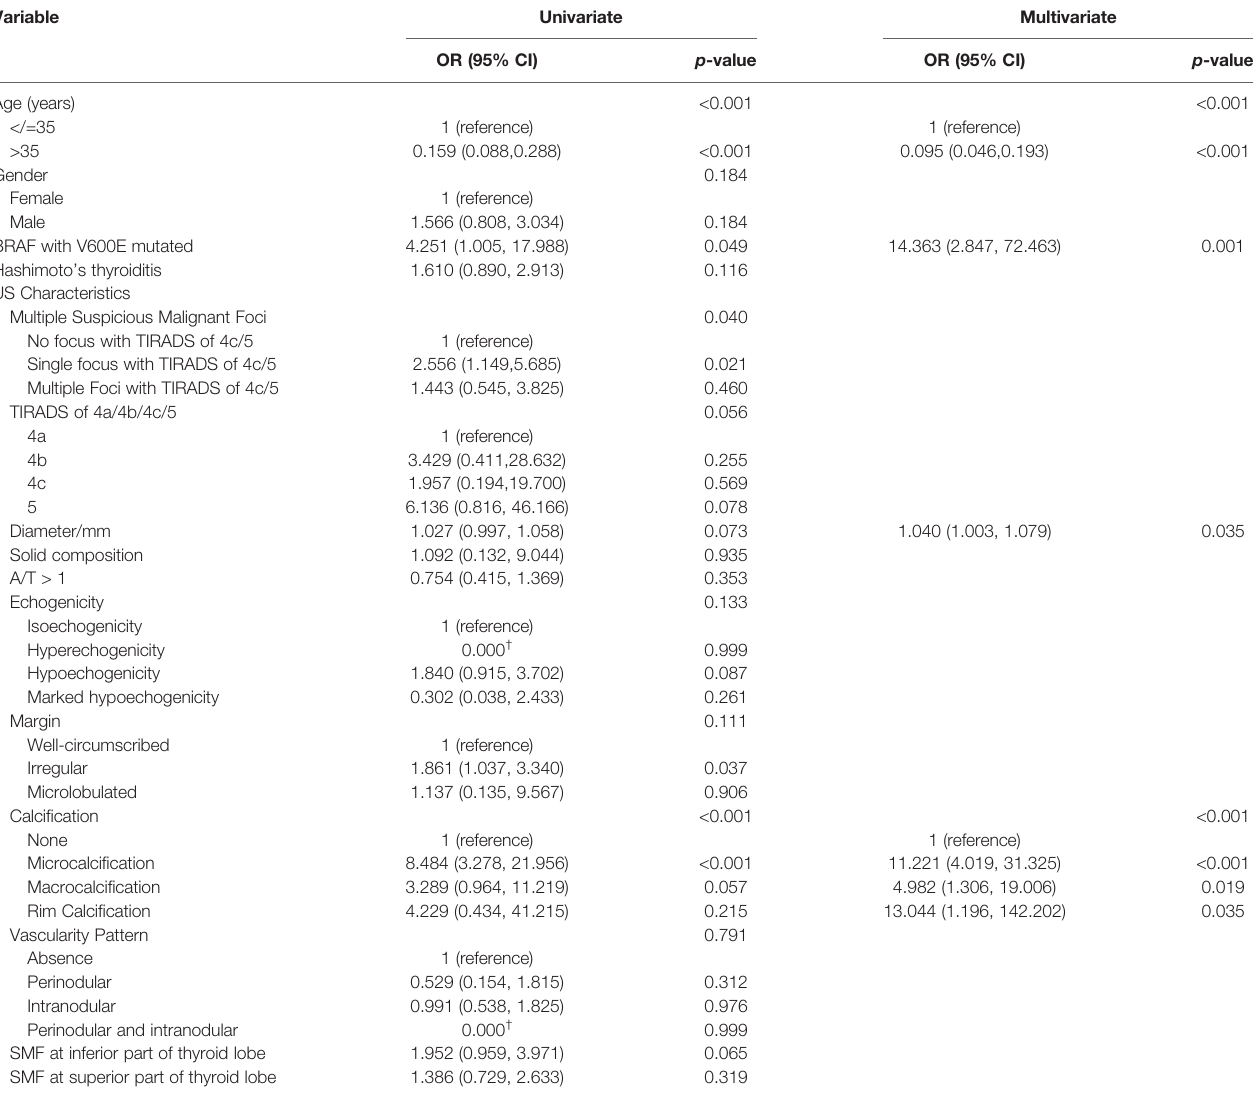
TABLE 2 | The results of logistic regression analysis.